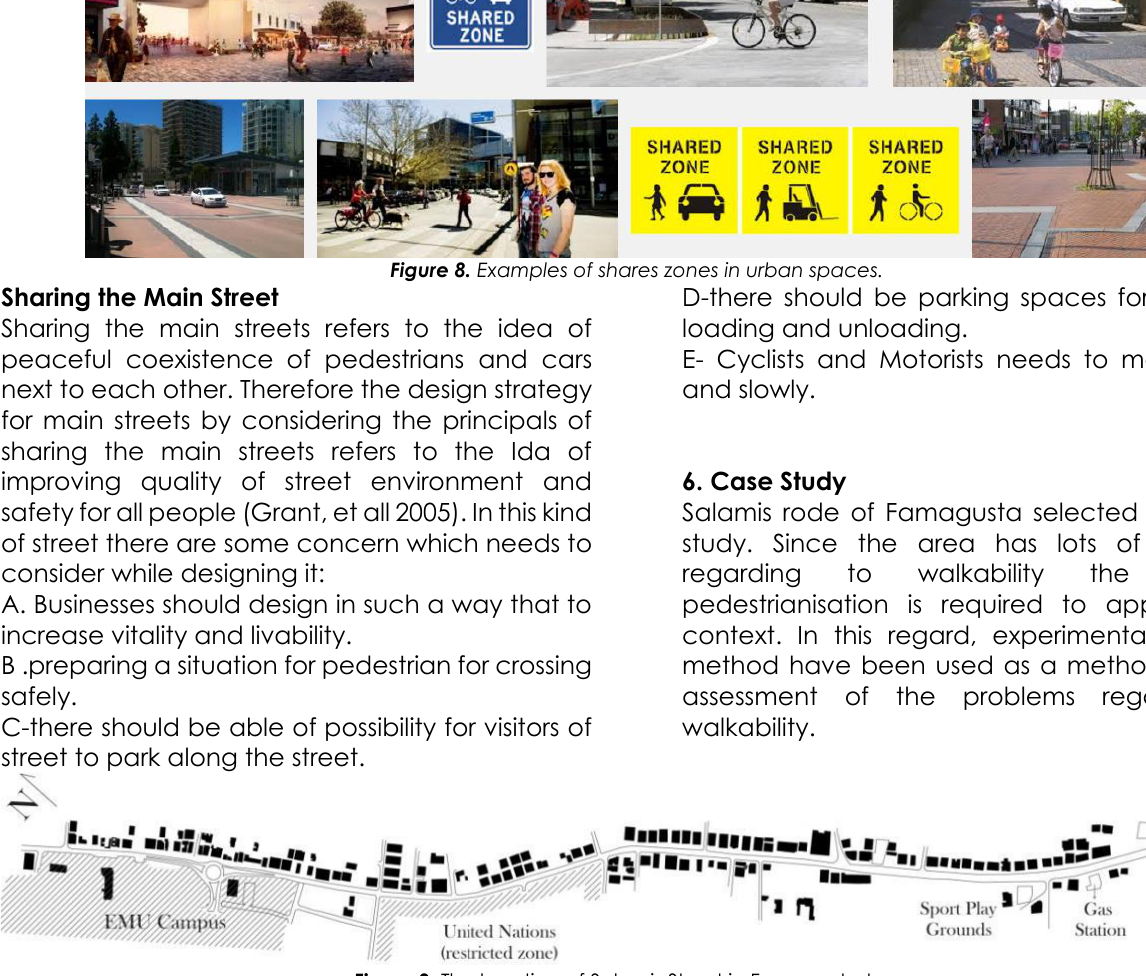
Figure 9. The location of Salamis Street in Famagusta